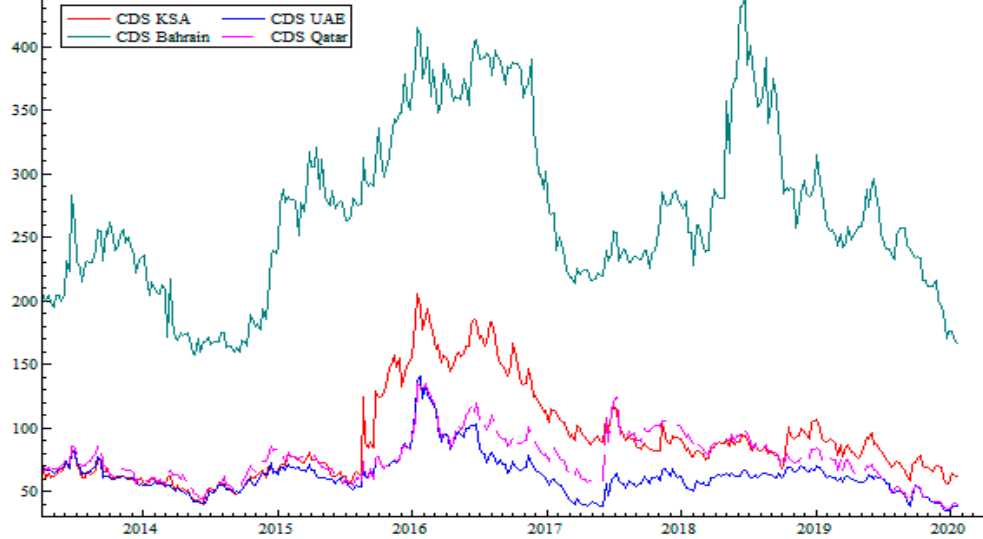
Figure 1. Time trend of the Gulf Cooperation Council (GCC) sovereign credit default swap (CDS) spreads.